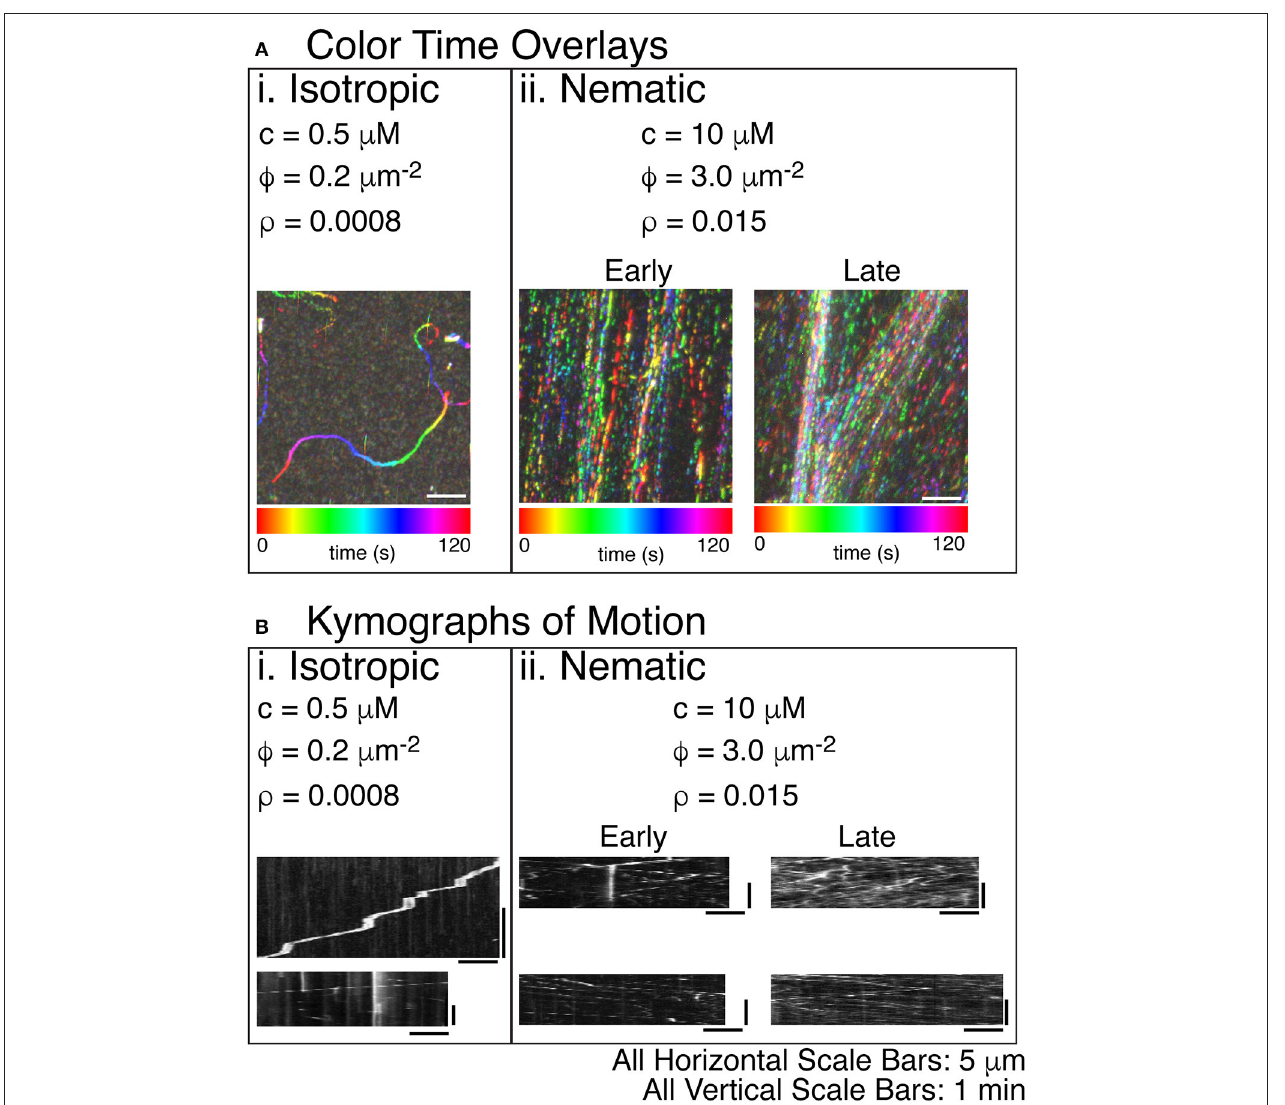
FIGURE 5 | Steady states of actin filament organization as a function of increasing actin filament density. (A) Color time overlays where each frame of a time series is overlaid as a different color, as indicated by the color scale bar. (i) Lowest concentrations of actin filaments display an isotropic phase with filaments pointing in all directions. The concentration (c) is 0.5 µ M actin monomers. The filament density ( ρ ) is 0.2 filaments per µ m 2 . The surface area fraction of filaments ( φ ) is 0.0008. The color time scale for this image is from 0 to 120s. (ii) The highest concentration of actin filaments displays a nematic phase with filaments co-aligning globally and moving in antiparallel directions throughout the space. The c is 10 µ M tubulin dimers. The ρ is 3.0 filaments per µ m 2 . The φ is 0.015. Filament alignment occurs rapidly, but the local density of the aligned filaments changes over time. Early images of these samples does not show density fluctuations—only global alignment. Later imaging of the same sample shows the accumulation of high density regions. The color time scale for these time series are from 0 to 120s. (B) In order to determine the direction of the filaments within the high-density regions of the images, we created kymographs where the image along the linear region of interest is sequentially layered for each time step. The time dimension is portrayed on the y-axis. The space dimension along the filament is portrayed along the x-direction. (i) For the lowest density of filaments, visible tracks in the color time overlays were used to create kymographs. These tracks were deposited by single filaments, as evidenced by the single trail of intensity in the kymographs. Some filaments were observed to pause because of interactions with some dead myosins (top). When unlabeled actin filaments were also included, all filaments were observed to move without pausing (bottom). (ii) For high densities of filaments, the denser regions of the color-time overlay were used to create kymographs. For early time movies, a single diffraction-limited region used for the kymograph still displayed filaments moving in both directions, even though the density was not as high. For the late time movies, the regions of high density show motion in both directions and a significantly higher number of filaments passing parallel to the diffraction-limited region. All scale bars in the x-direction are 5 µ m for all images. All scale bars in the y-direction were 1min in time for all kymographs.